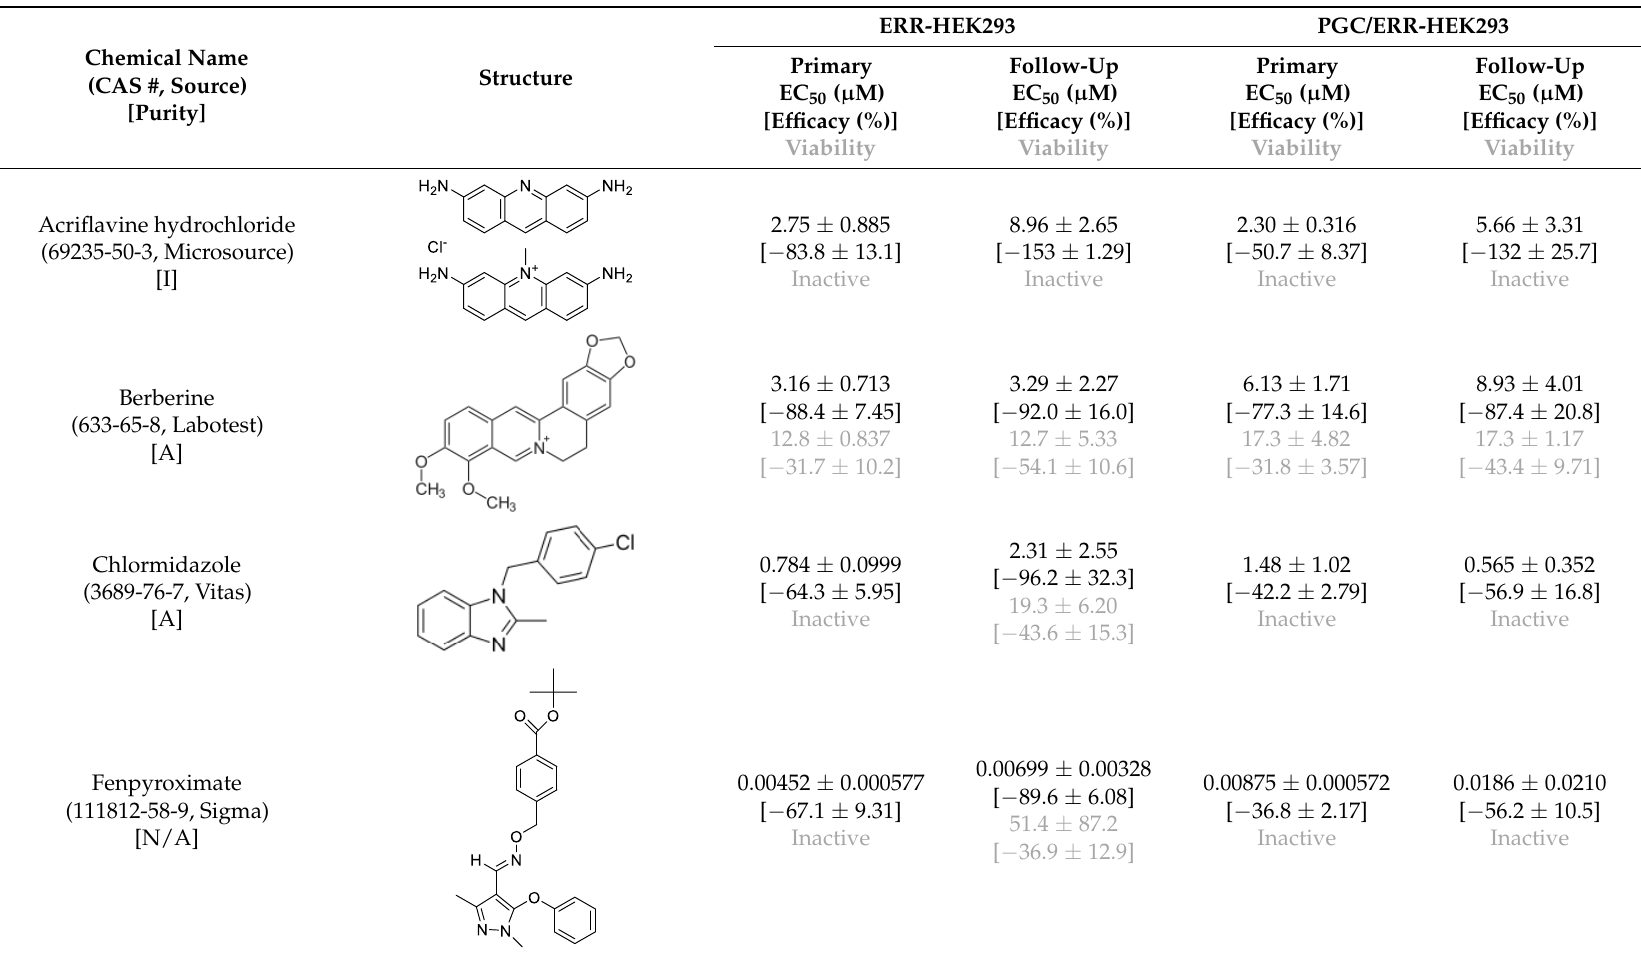
Table 2. Pesticide compound qHTS primary and confirmation ERR and PGC/ERR EC 50 and efficacy data.